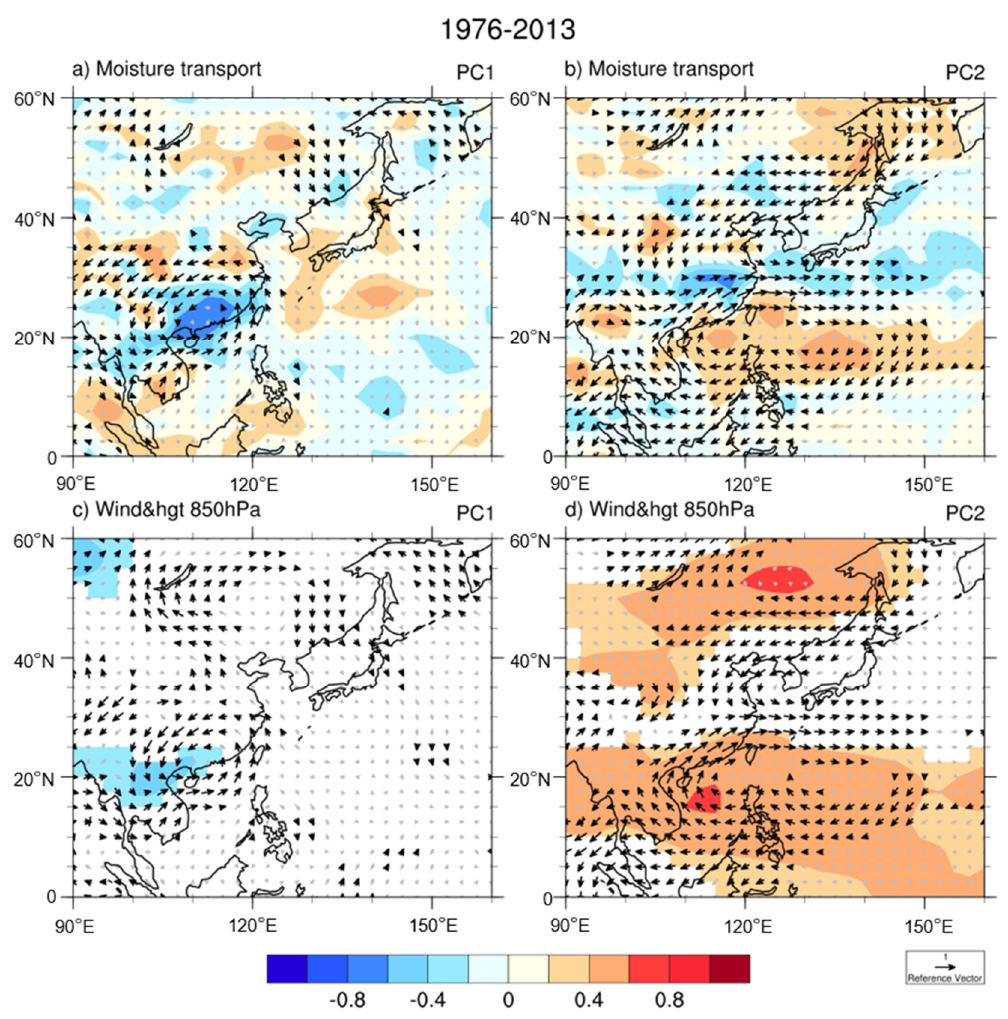
Figure 8. Correlation of water vapor transport (upper) and 850 hPa wind and geopotential height (lower) against PC1 ( a , c ) and PC2 ( b , d ).